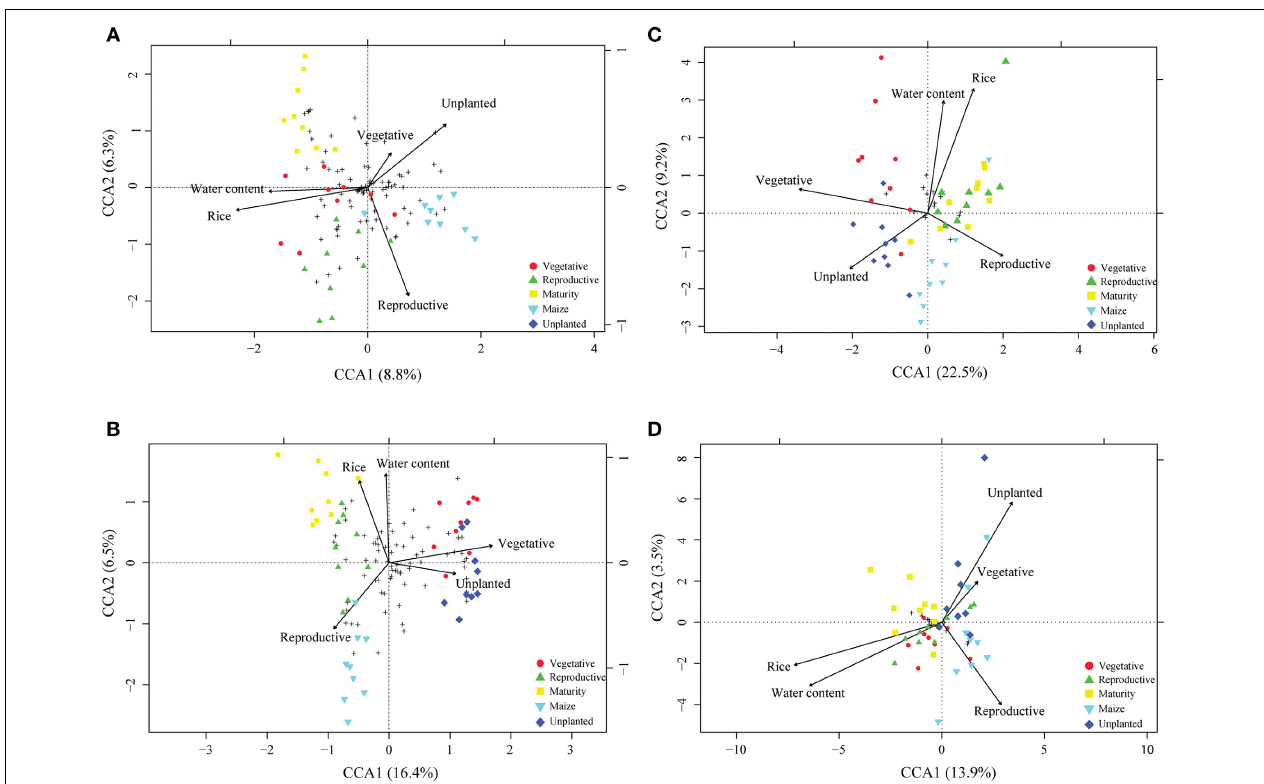
FIGURE 3 | Canonical correspondence analysis (CCA) biplot of T-RFLP based on bacterial and archaeal communities. T-RFLP based communities of bacterial 16S rDNA and rRNA (A,B) as well as archaeal 16S rDNA and rRNA (C,D) are displayed. Arrows indicate the direction and relative importance (arrow lengths) of environmental variables associated with bacterial and archaeal community structures, respectively.